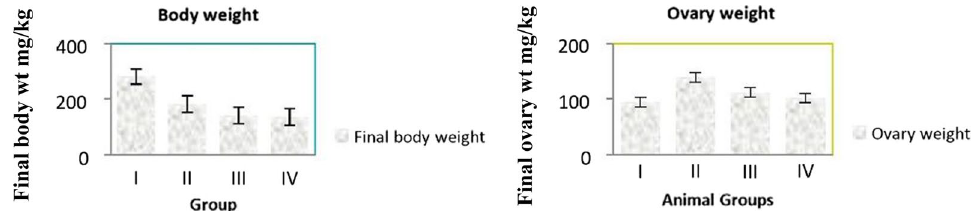
Fig. 11 Effect of T. viride fungal crude extract on body weight and ovary weight